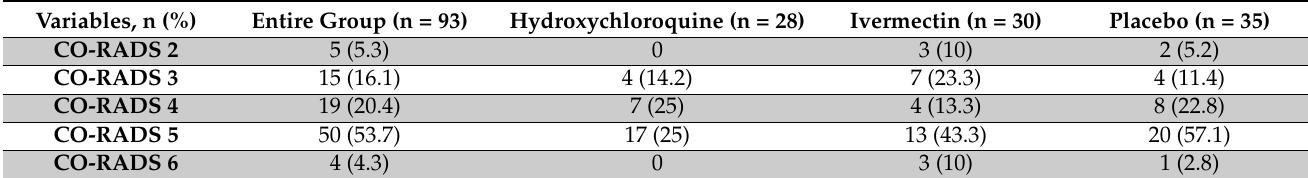
Table 2. Computed Tomography Characteristics.